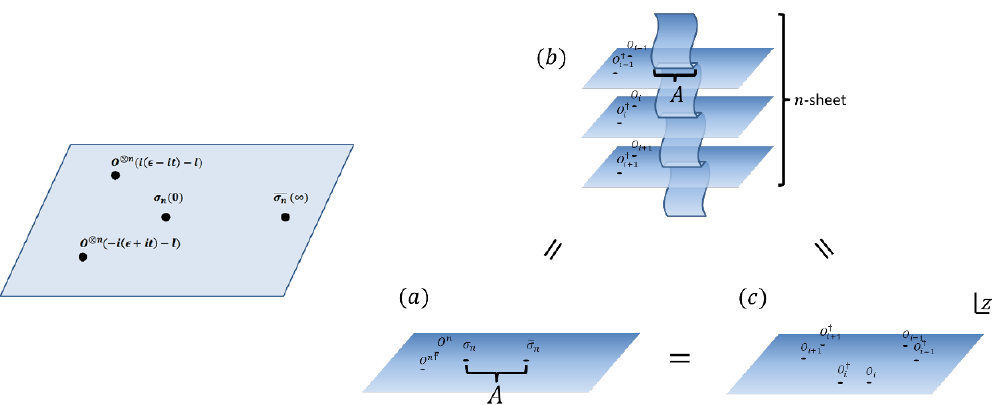
Figure 8 . (Left) The positions of operators in the replica computation (3.46). (Right) The equiv- alence between ( a ) and ( b ) explains the relation between a correlator with twist operators in an orbifold theory and a replica manifold. The equivalence between ( b ) and ( c ) can be obtained using a conformal map w = z n